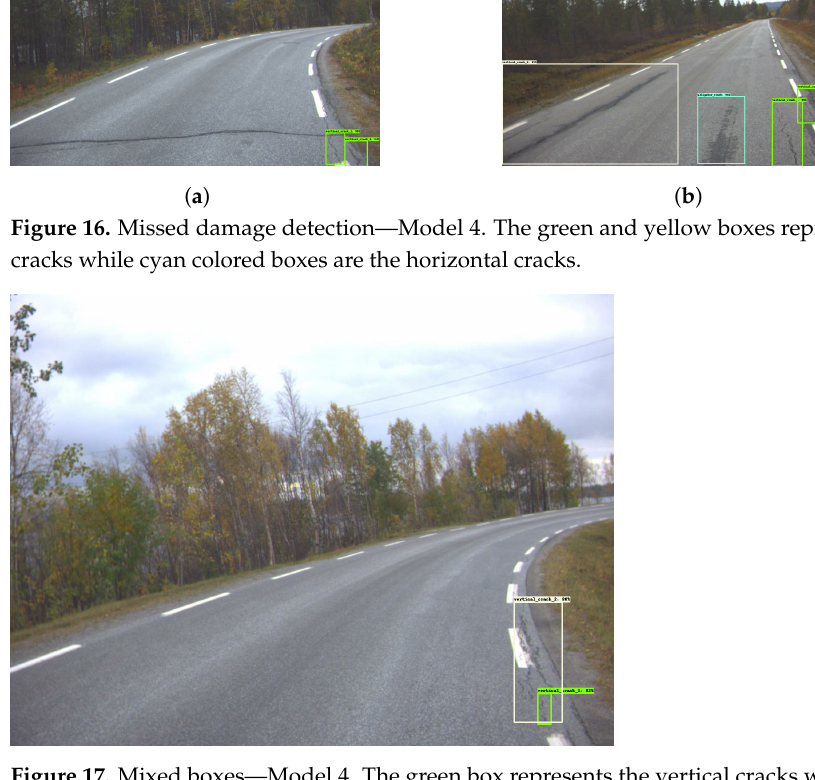
Figure 17. Mixed boxes—Model 4. The green box represents the vertical cracks while cyan colored box is the horizontal